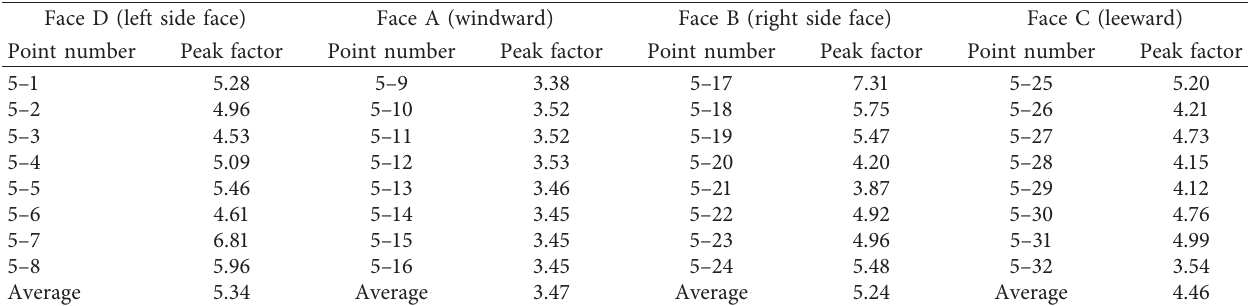
Table 4: Peak factors with 99% guarantee rate calculated by the stepwise search method (on the 5 th measurement level at 90 ° wind direction angle).